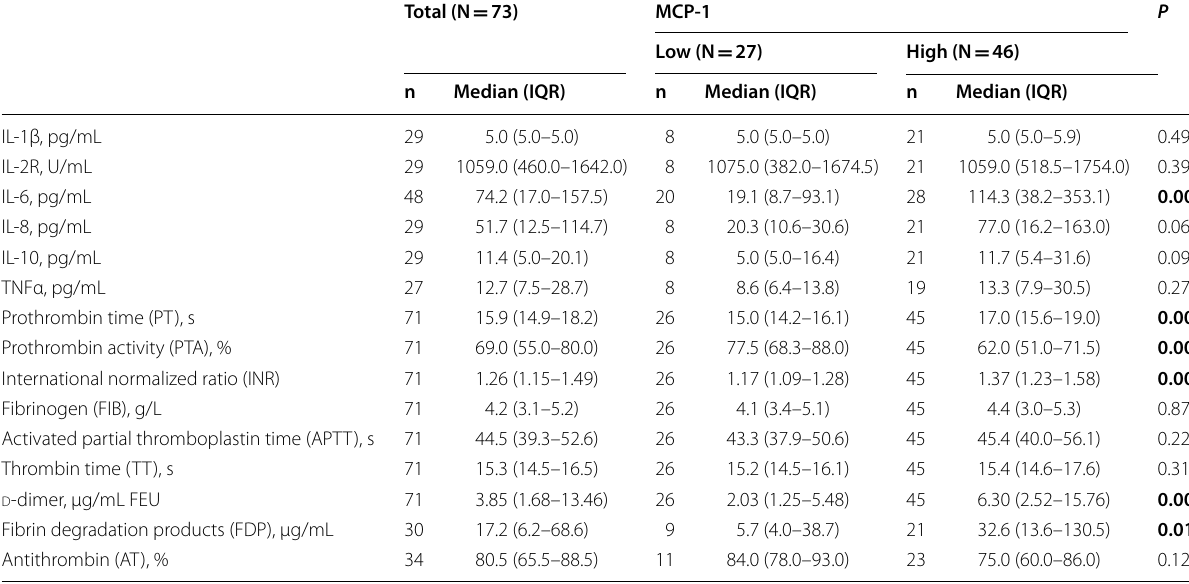
Bold indicates the statistically significant values ( P < 0.05)